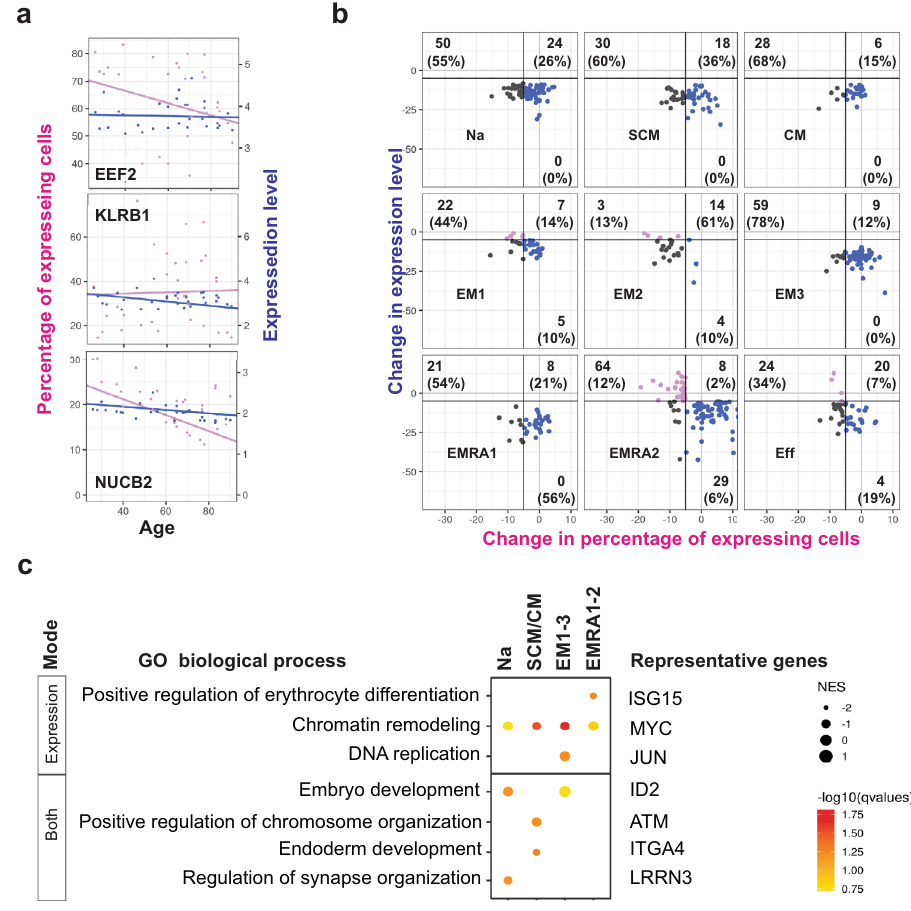
Fig. 4 | Modes of age-associated reduced gene expression in CD8 + T cell sub- populations. a Scatter plots showing examples of gene expression that decrease across aging in each of three modes (EEF2 – percentage, KLRB1 – expression, NUCB2 – both).Trendlineswerefromthelineageregressionmodelforwhichthet distribution with n-2 degrees of freedom was used to evaluate if a slope was sig- ni fi cant for a particular variable (2 sided t-test). b Scatter plots categorizing genes